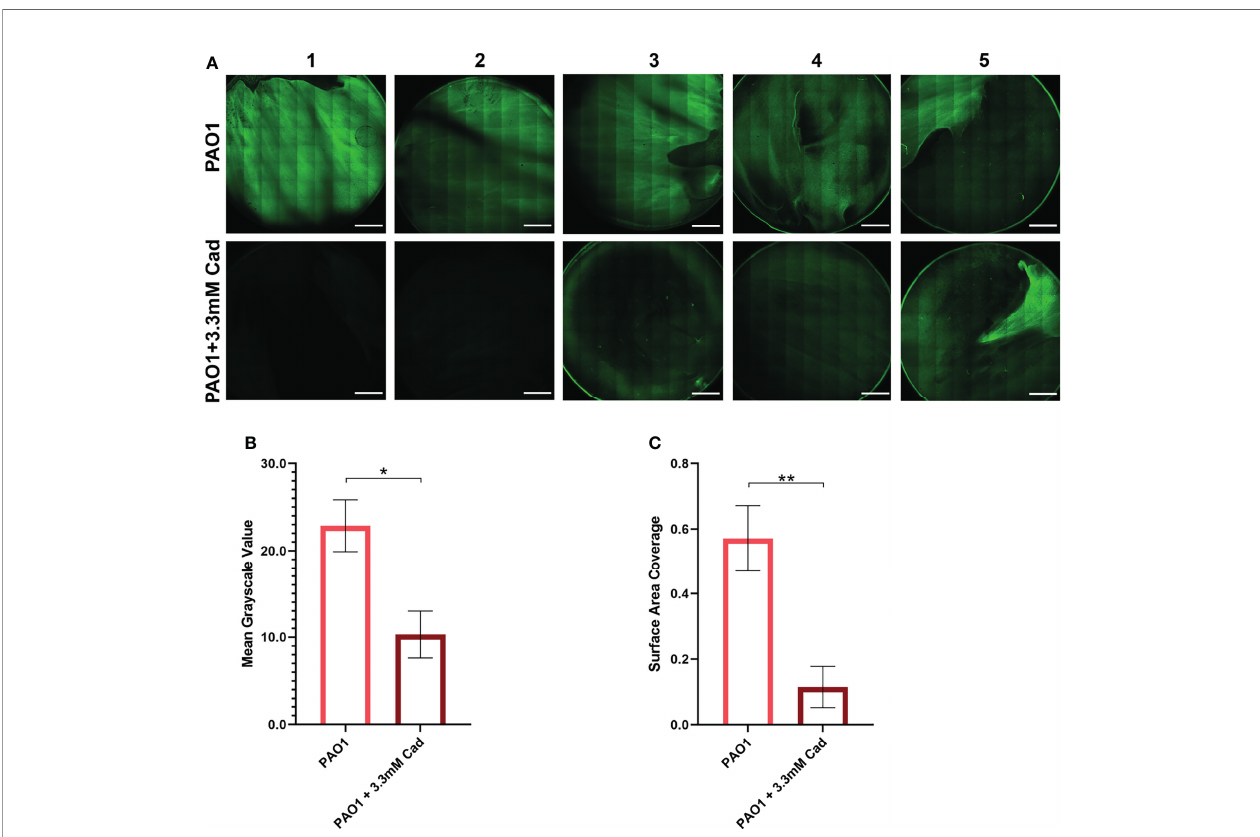
FIGURE 6 | Stitched confocal microscopy images show a signi fi cant reduction in bio fi lm accumulation with cadaverine by image quanti fi cation. (A) 3.30mM cadaverine (cad) is supplemented to the PAO1 culture in a 35 by 10mm dish, grown 24 hrs, stained with SYTO 9, and stitched confocal images (n=5; paired to control cultures) are taken at laser power 4.5%. Scale bars in the lower right corner of images represent 0.2 cm. Images are quanti fi ed in Fiji by (B) mean grayscale value and (C) surface area coverage with the auto threshold set to 13 and asterisks denote signi fi cance (* p < 0.05, ** p < 0.01 by unpaired, two-tailed t -test). Mean grayscale value and surface area coverage show 55% and 80% reduction in bio fi lm accumulation, respectively, with supplementation of